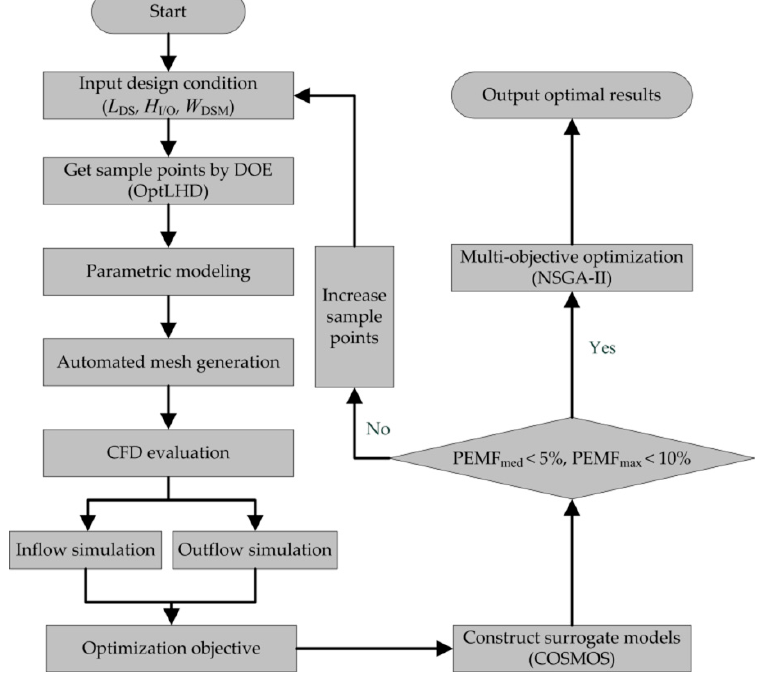
Figure 10. Flow diagram of the multi-objective optimization process.